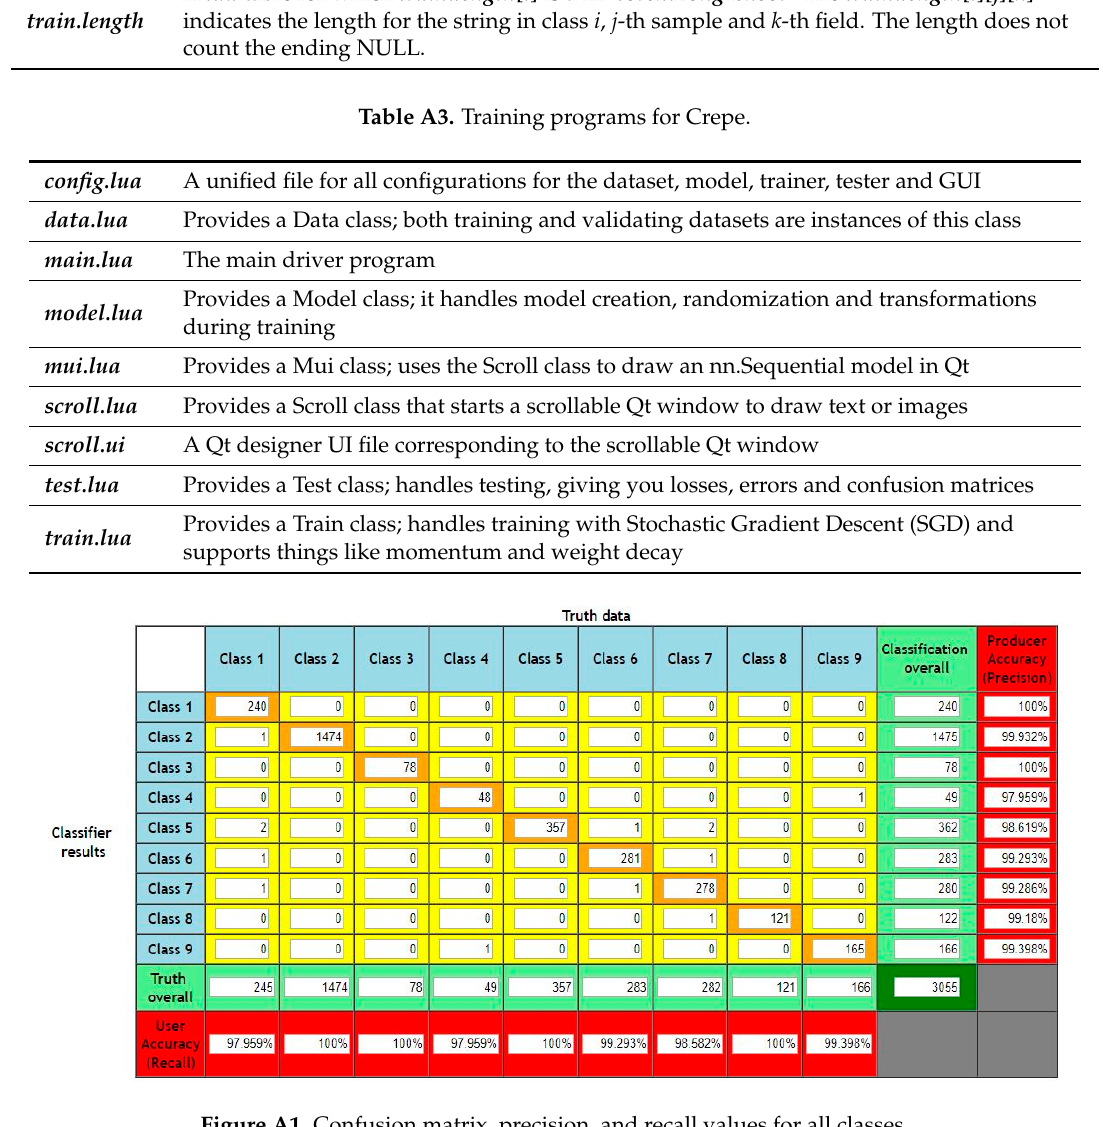
Table A2. Members of the variable train.